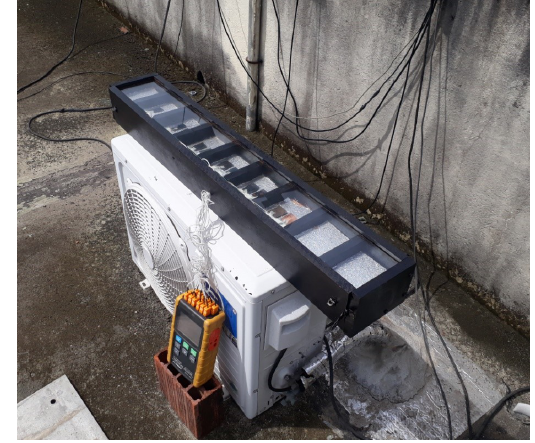
Figure 2: Experimental bench for tests in the